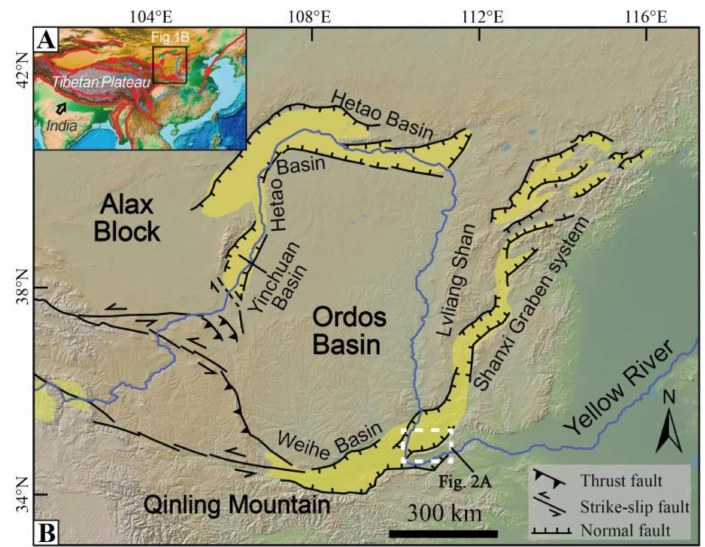
Figure 1. ( A ) Simplified tectonic and geomorphological map of the Tibetan Plateau and its adjacent areas. The black rectangle shows the location of Figure 1B. ( B ) Topographic map of the Ordos Block and its adjacent areas; reported are the major faults and the Yellow River course showing on. The yellow shaded areas show the locations of the Cenozoic sedimentary basins. The sedimentary basins and the faults are modified from [28]. The white dashed rectangle highlights the localization of Figure 2A and of the study